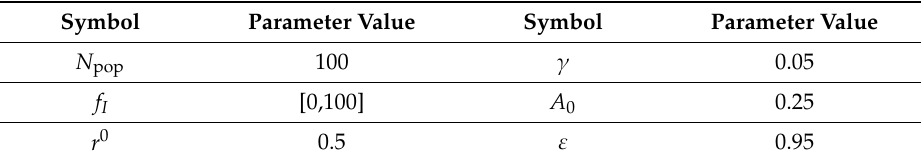
Table 3. Performance comparison of BA and improved BA.